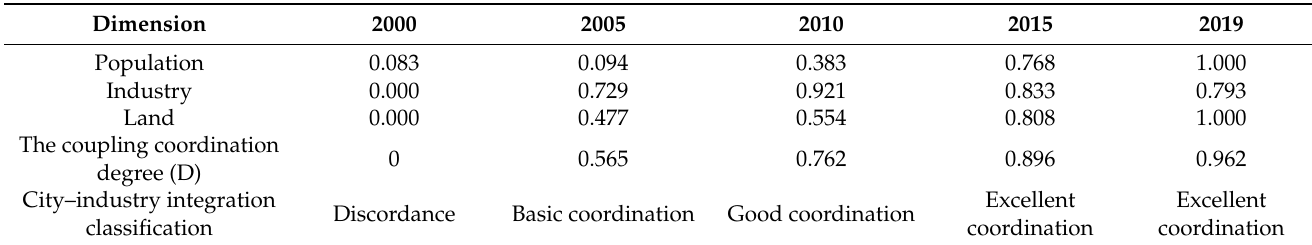
Table 8. Evaluation results for the city–industry integrated development of